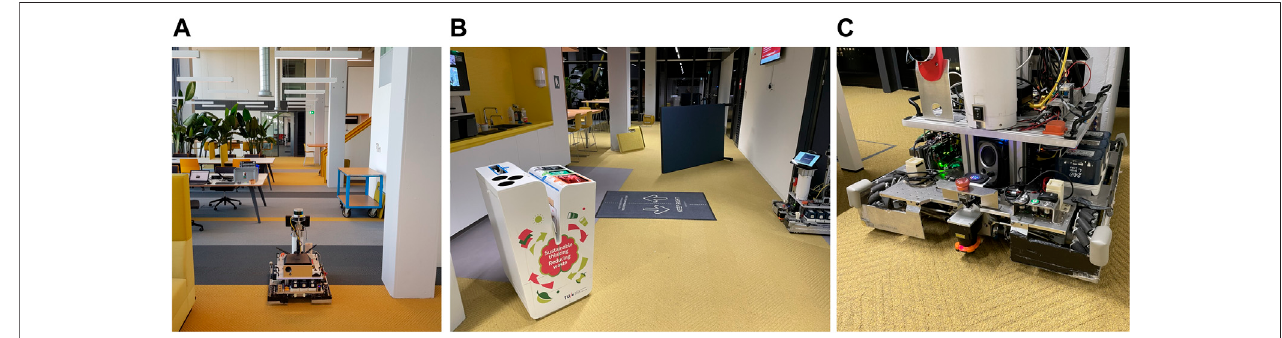
FIGURE 7 | (A) The robot platform in the Atlas environment, the position is indicated in the map in Figure 9 position 1 (oriented towards the left). The situation shown is used as scenario A, where unmapped items are on the map in the form ofchairs, tables and carts. (B) Some of the disturbances added to a part of the map to purposely obscure or mimick features for scenario (C) A close up of the robot platform with the planar LiDAR sensor.